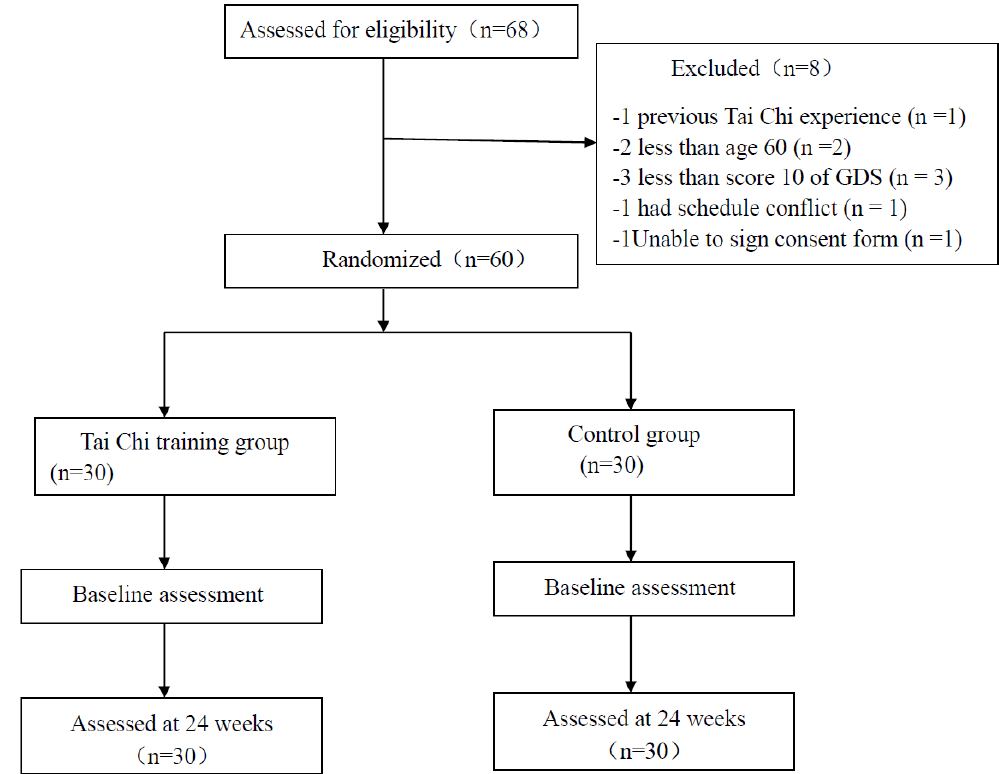
Figure 1. Flow diagram of eligibility assessment, exclusion, inclusion, and analysis.